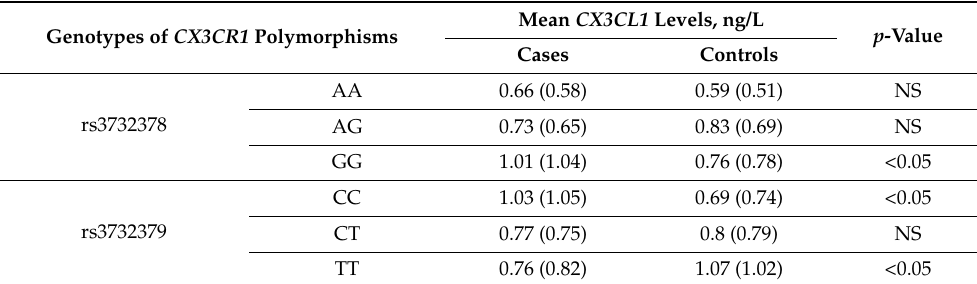
Table 5. Differences in mean fractalkine ( CX3CL1 ) levels between patients with end-stage renal disease (cases) and controls by the genotype of rs3732378 and rs3732379 polymorphisms. Genotypes of CX3CR1 Polymorphisms